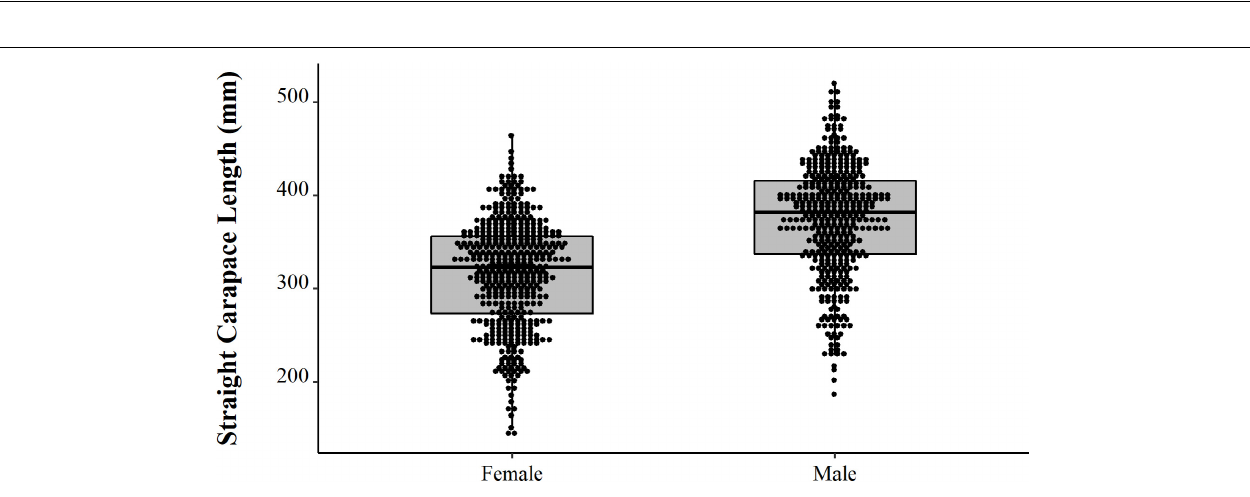
FIGURE 6 | Temporal distribution (points) and descriptive statistical (boxplot) of body size (SCL, mm) of the male and female Big-headed ( Peltocephalus dumerilianus ) from the Jaú collected between 1997 and 2019.